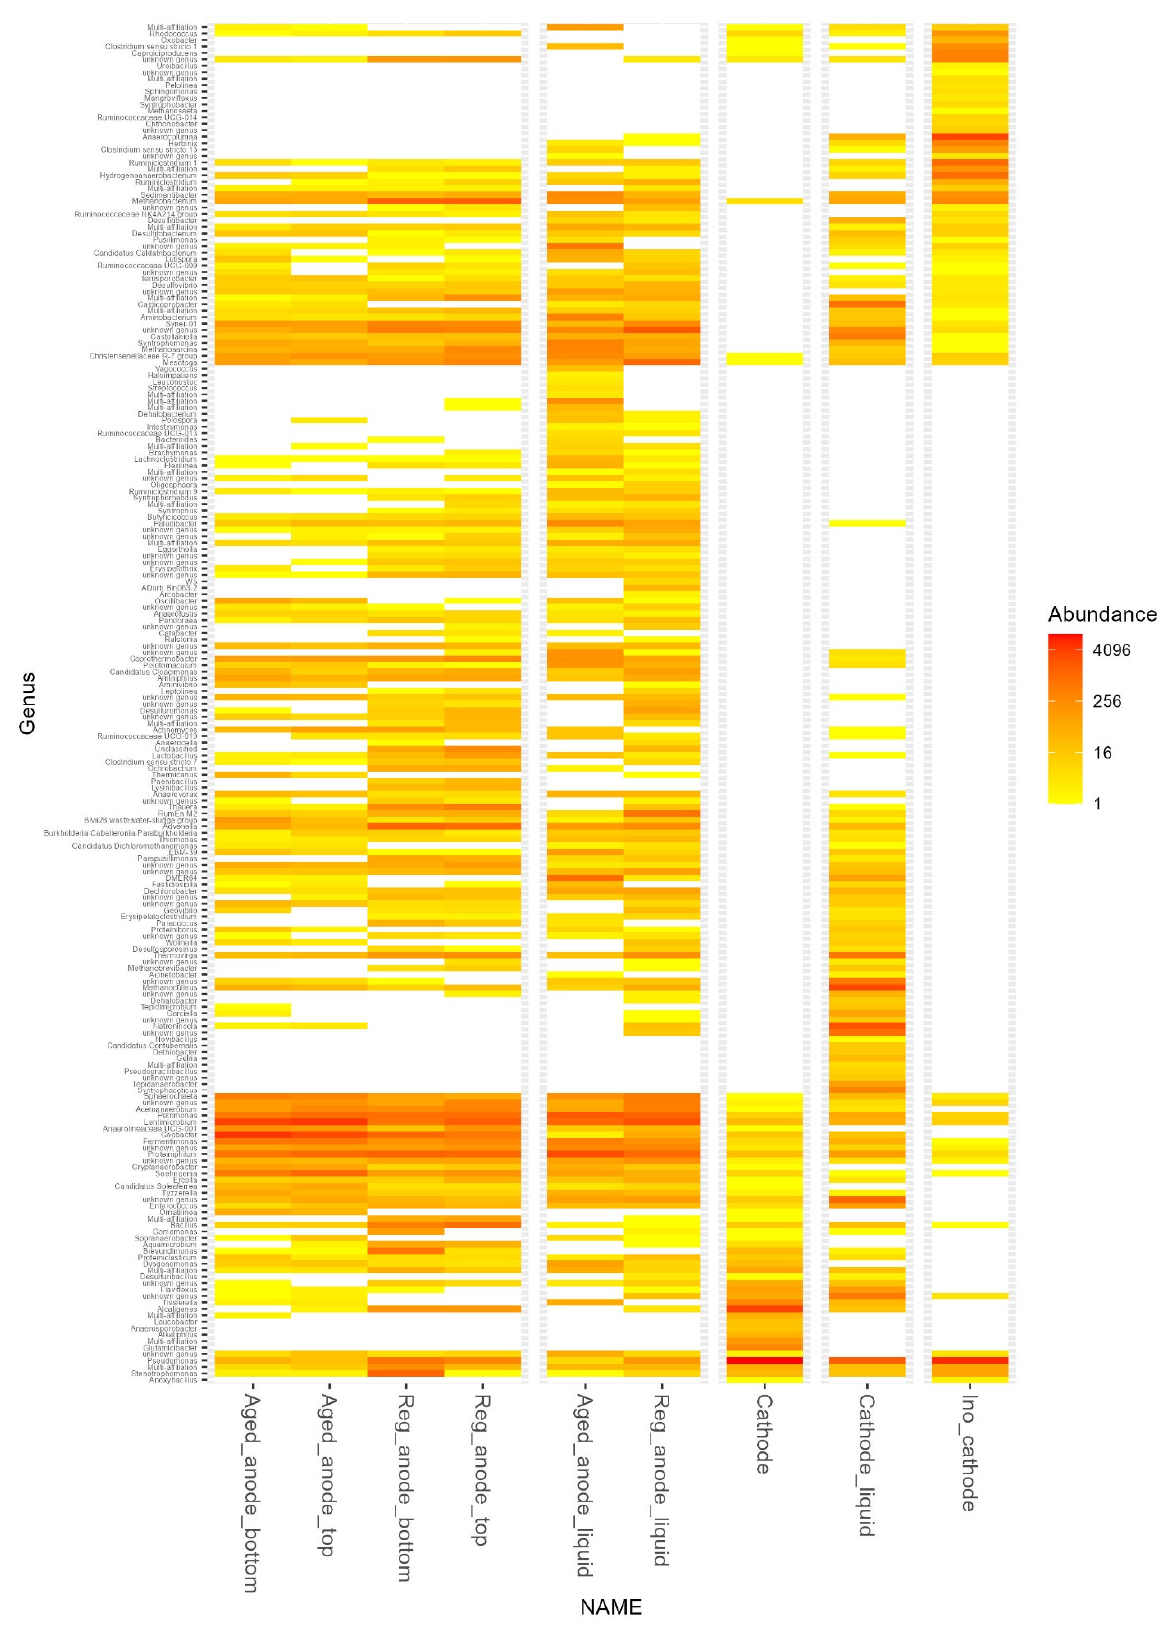
Figure 9. Heat map of the microbial community composition at Genus level for the different samples analyzed.